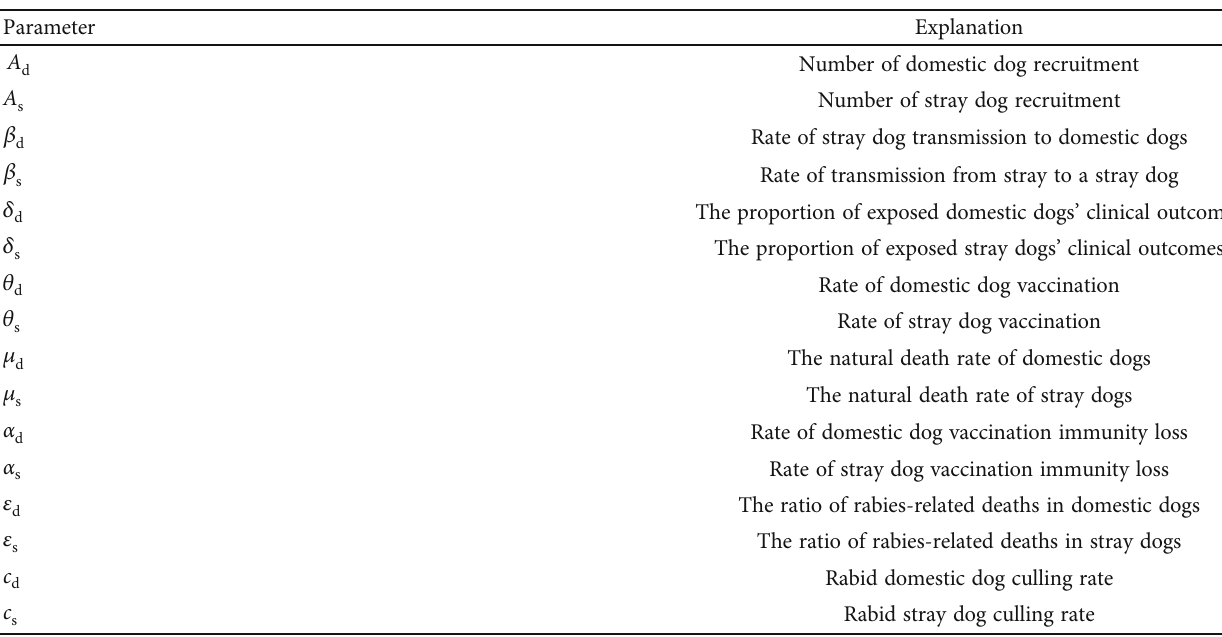
Table 2: Details of the model